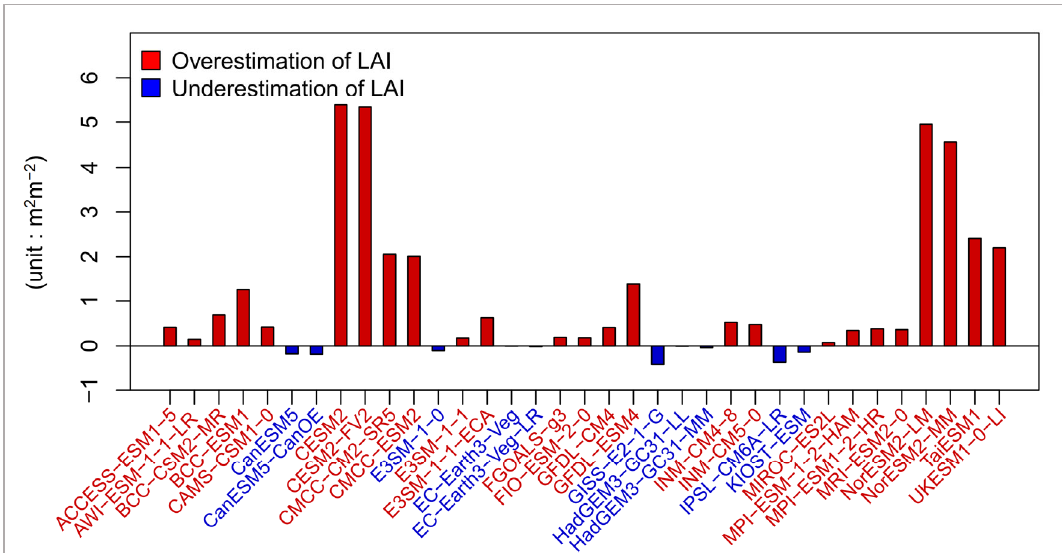
Figure 2. The bias of the area ‐ averaged LAI during the growing season in Tibetan Plateau from 1981 to 2014 between each CMIP6 model and GLASS data.